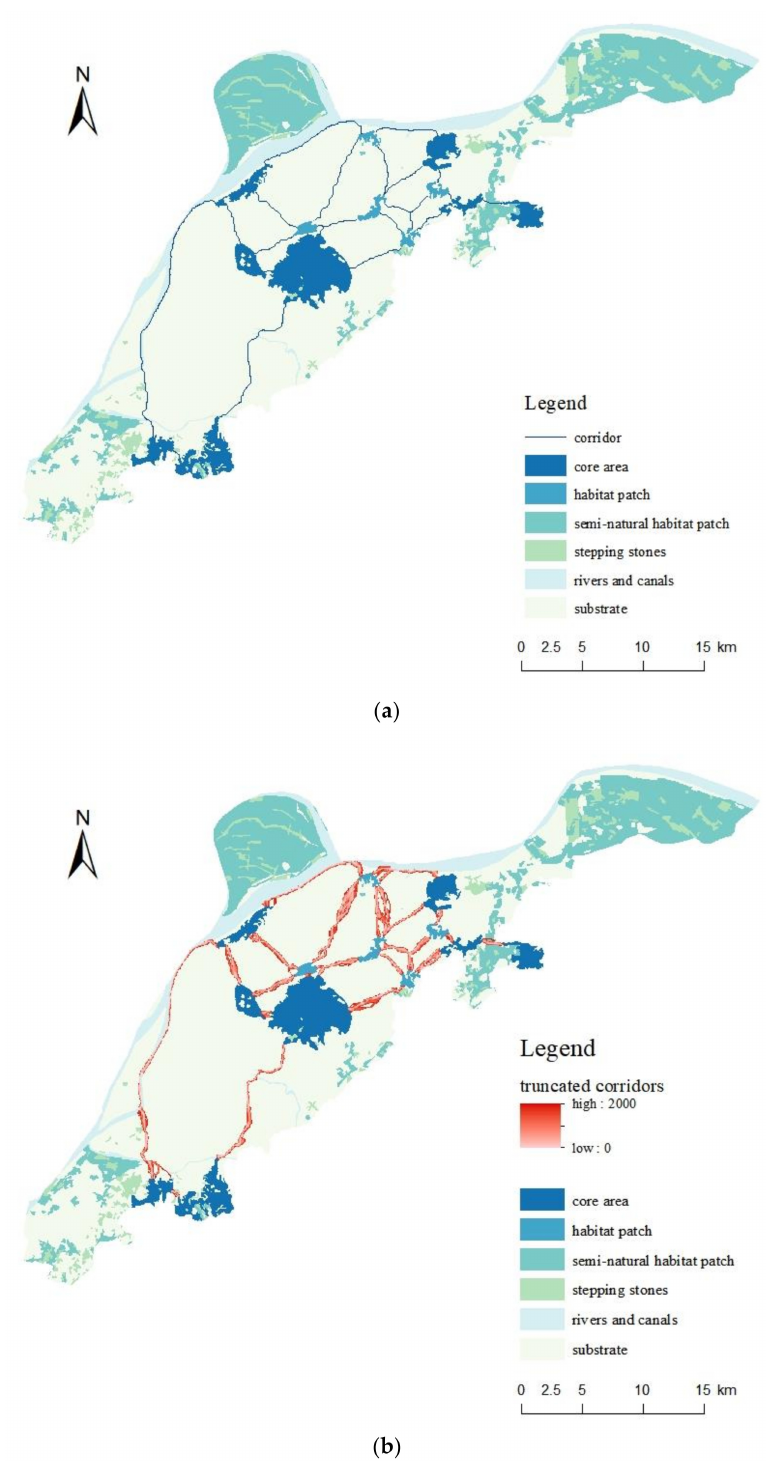
Figure 4. Result of the simulation of the habitat network in Nanjing’s main urban area: ( a ) results of the simulation of the habitat network; ( b ) results of the simulation of ecological flow